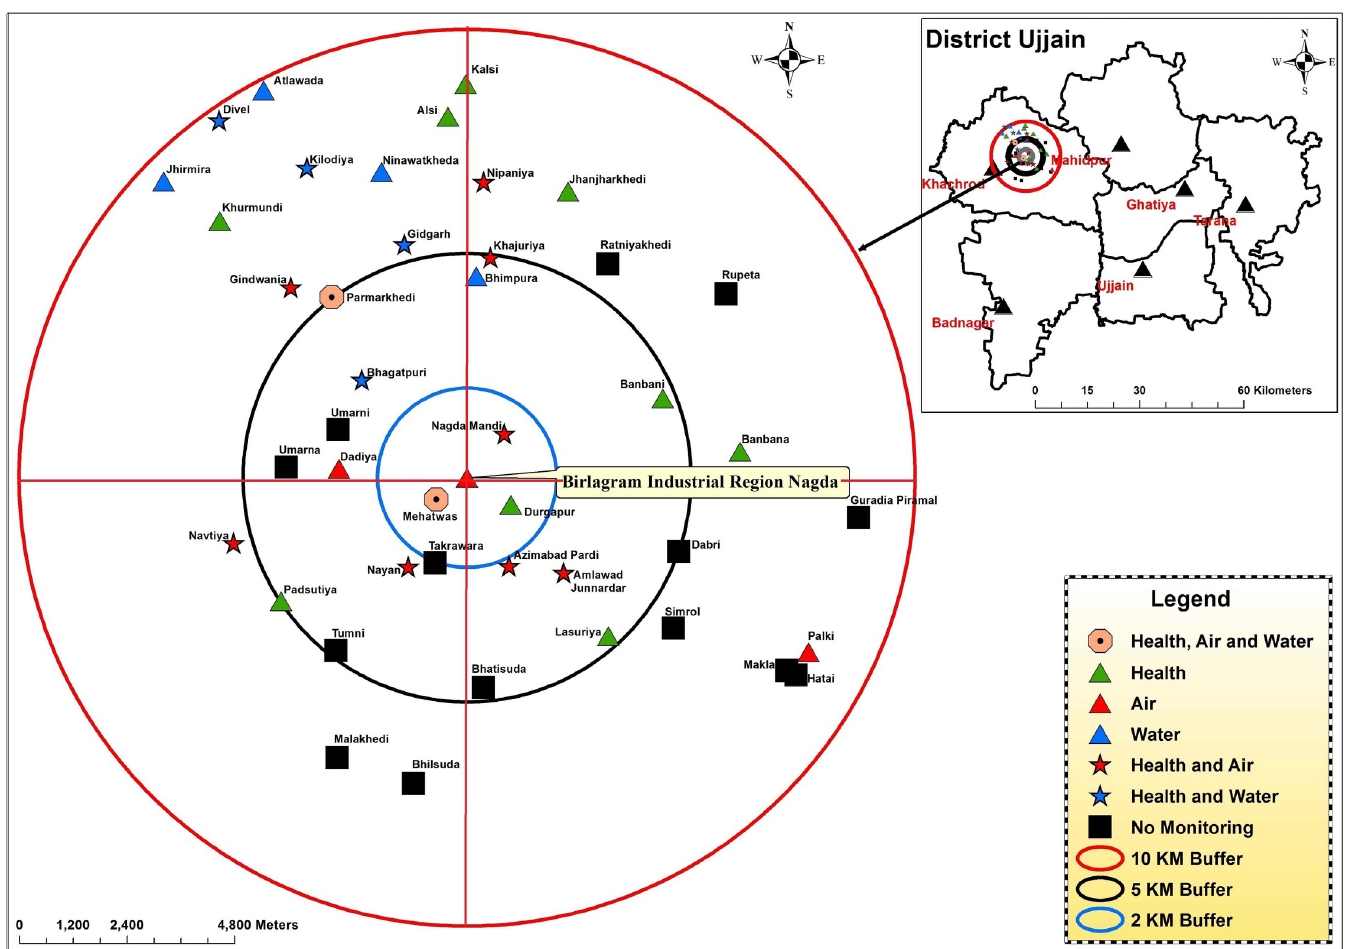
Fig 3. Map of the study area created by research team to assist in selection of exposure monitoring locations and in participant sampling. [Note: The inset in the map shows the Ujjain district of the central Indian province of MP. Within the Khachrod Tehsil of the Ujjain district, lies the study area of the current project. Considering the Birlagram industrial region as the centre, three concentric circular regions were demarcated based on distance (2, 5 and 10 km from the centre)].